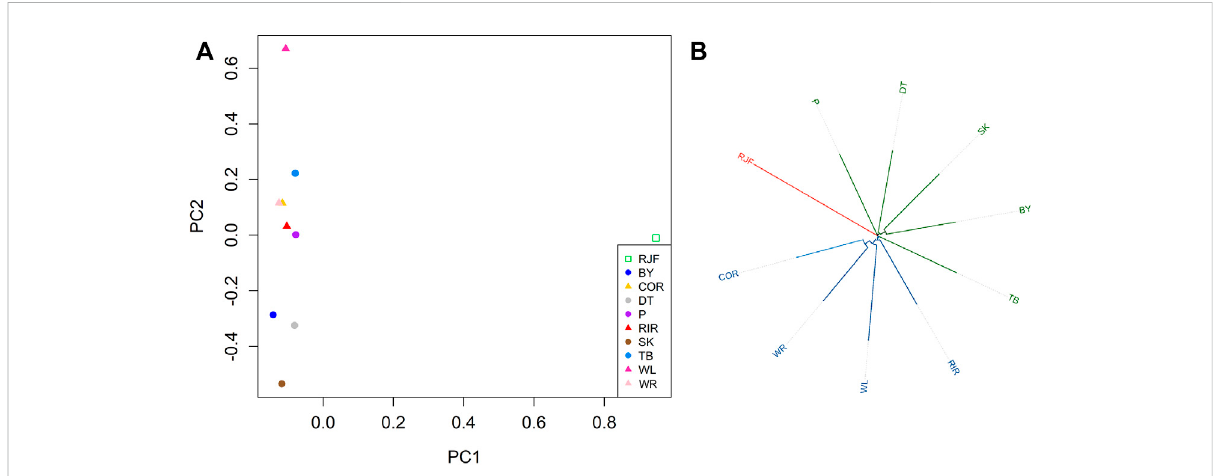
FIGURE 6 Genetic structure of SVs in different chickens. (A) PCA analyses; (B) Phylogenetic tree. Note: Silkies (SK); Tibetan (TB); Beijing You (BY); Piao (P); Dongtao (DT); Cornish (Cor); Plymouth Rock (WR); White Leghorn (WL); Rhode island Red (RIR); Red jungle fowl